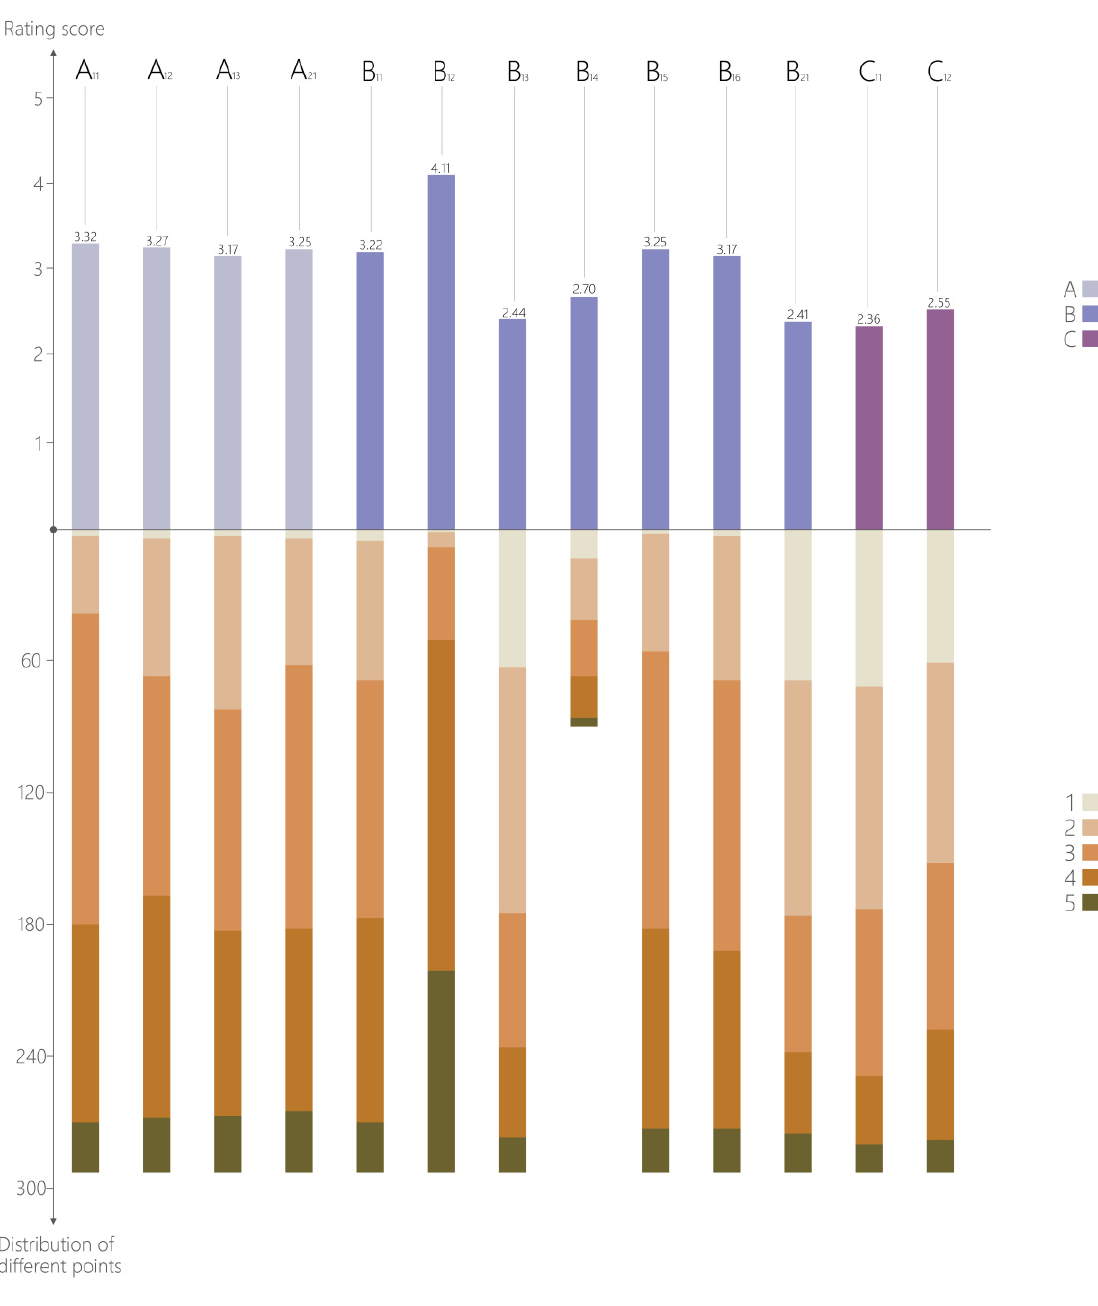
Figure 11. Statistical table of questionnaire results for the Nanpu Times traffic flow design.